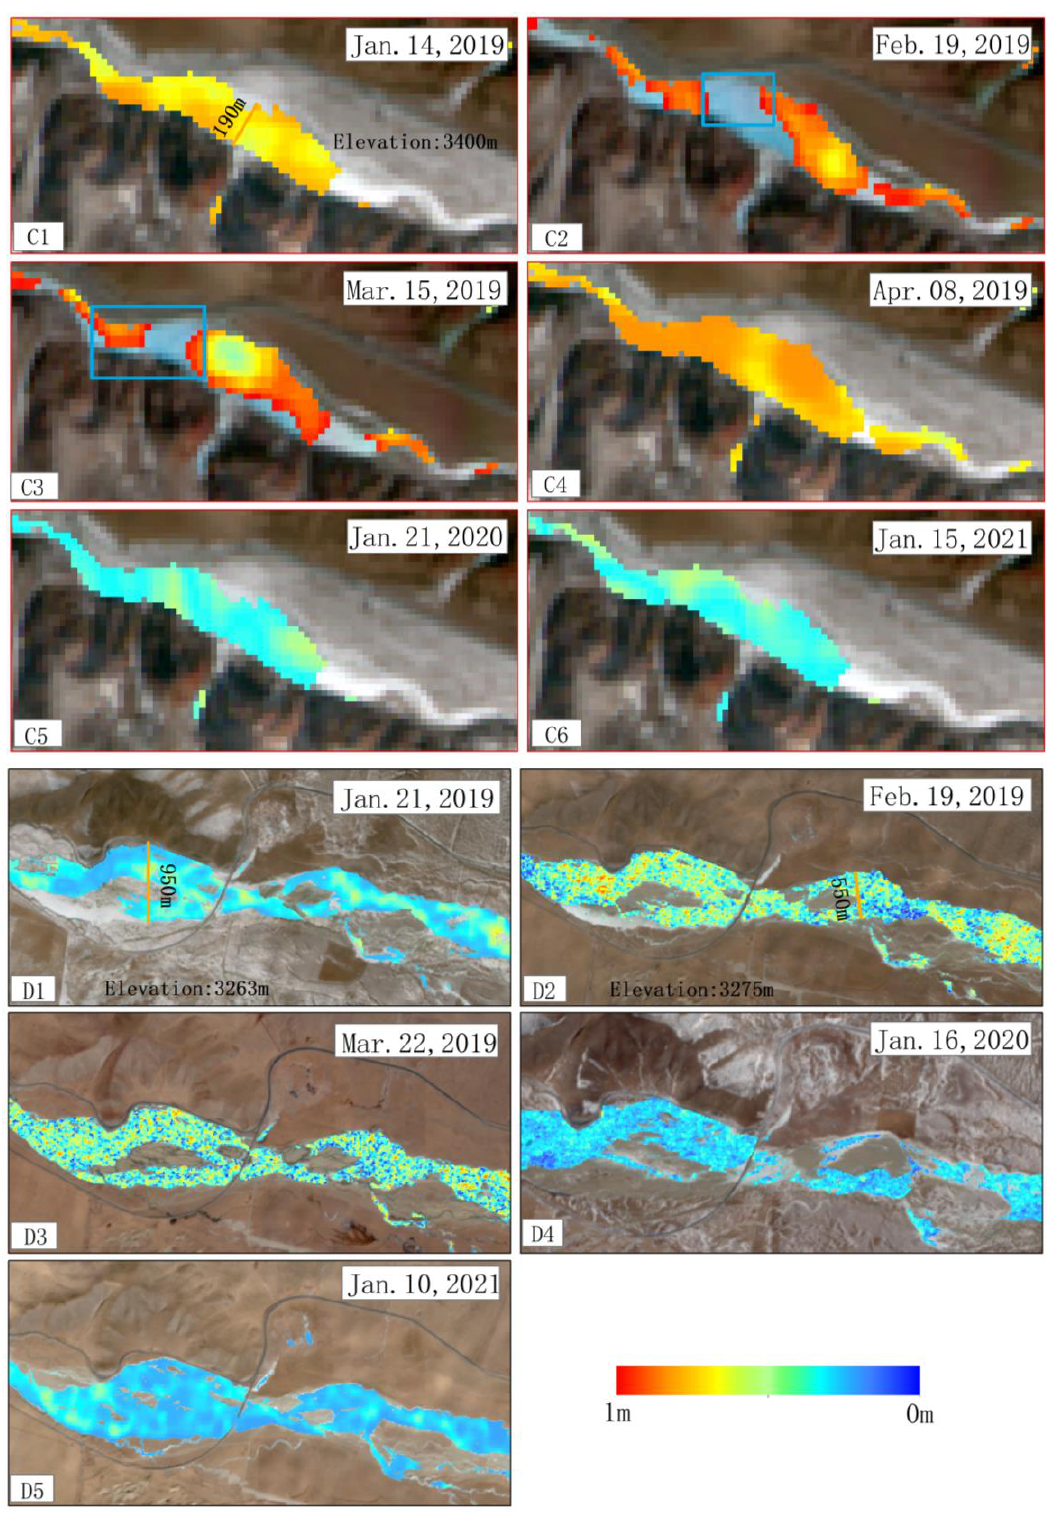
Figure 15. Effect of river ice thickness on the RMSE with the spatial distribution of river ice thickness. Panels ( A , B ) are plots reflecting the effect of river ice thickness on the RMSE, while ( C1 – C6 , D1 – D5 ) are maps of the spatial distribution of river ice thickness in individual areas. The orange line indicates the width of the river; the blue boxes indicate the areas with large inversion errors.